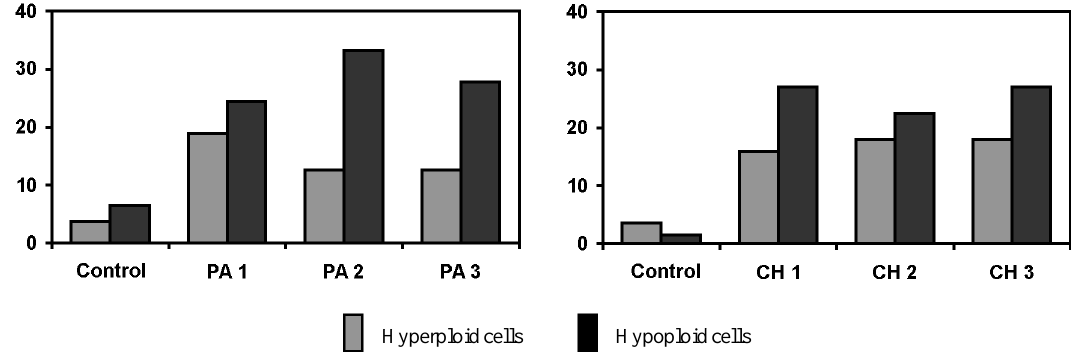
Hyperploid cells Figure 4 - Percentages of hypoploid and hyperploid CHED cells after treatment with propionaldehyde doses of 5 x 10 -4 % (PA1), 1 x 10 -3 % (PA2) and 2 x 10 -3 % (PA3) for 3 h and chloral hydrate doses of 1 x 10 -3 % (CH1), 2 x 10 -3 % (CH2) and 3 x 10 -3 % (CH3) for 1.5 h.